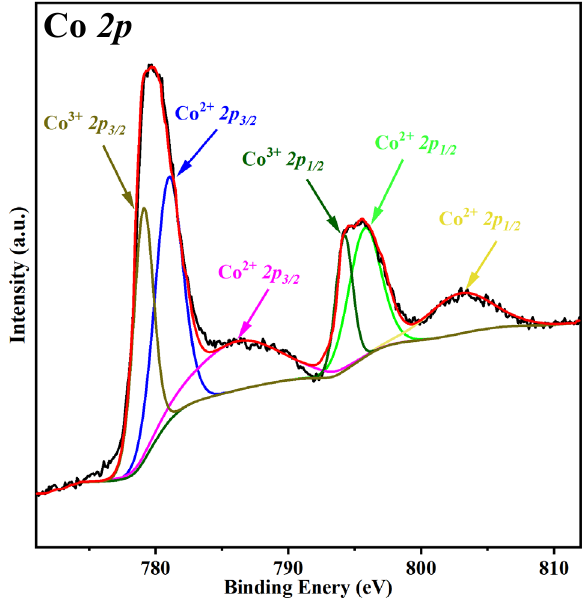
Figure 3. XPS spectra of Co 2p for Co/ETS-10 catalyst sample.